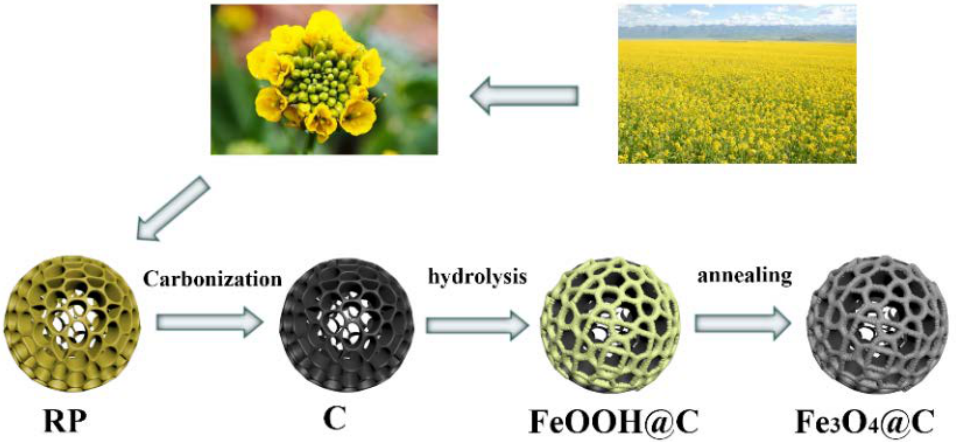
Scheme 1. The preparation process of porous Fe 3 O 4 @C composite.